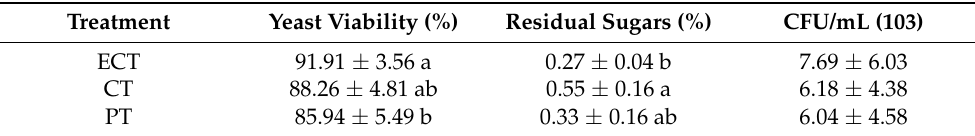
Table 2. Final yeast viability, residual sugars and contamination of fermented energy cane juice (ECT), corn (CT), and corn plus energy cane (PT).